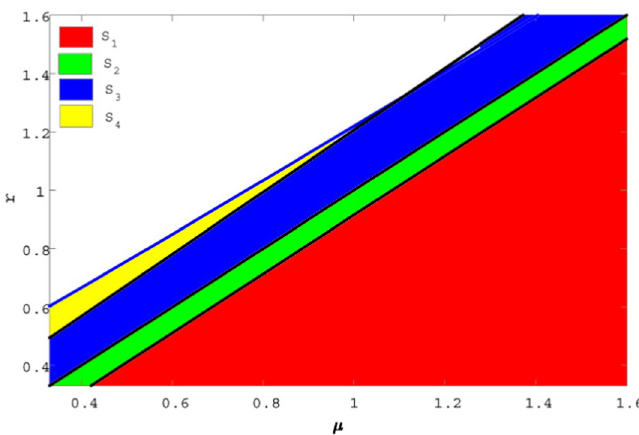
Fig. 12 Existence of stable–unstable region of the integer-order model